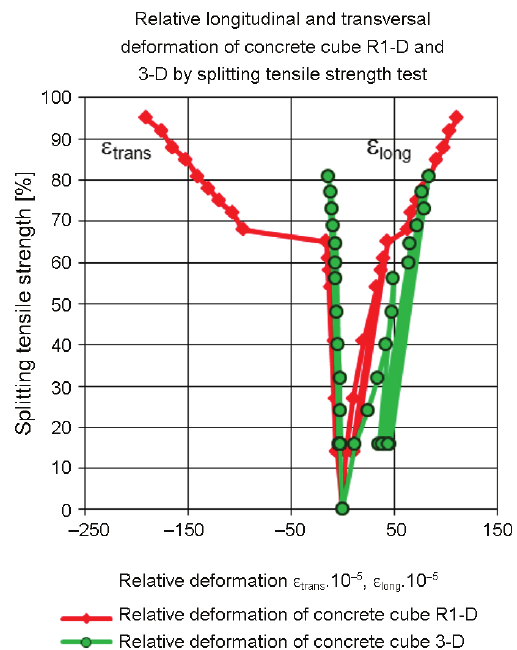
Fig. 7. Stress-strain diagram of concrete cube R1-D and 3-D under splitting tensile strength test